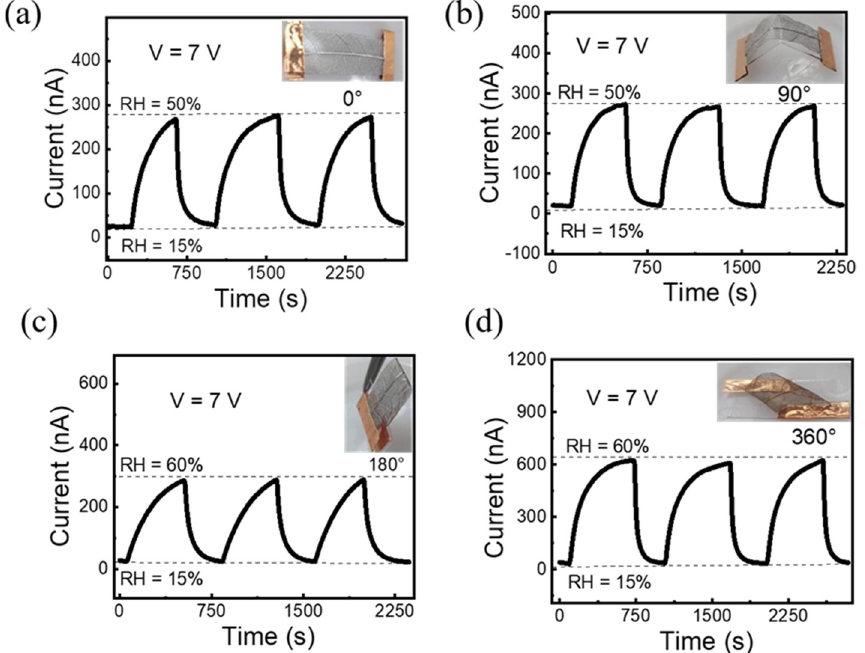
Figure 6. Flexibility test. The device tested under different bending angles (0–360°) with fixed bias (V = 7 V). The inset images indicate the sensor under different bending conditions ( a – d ).